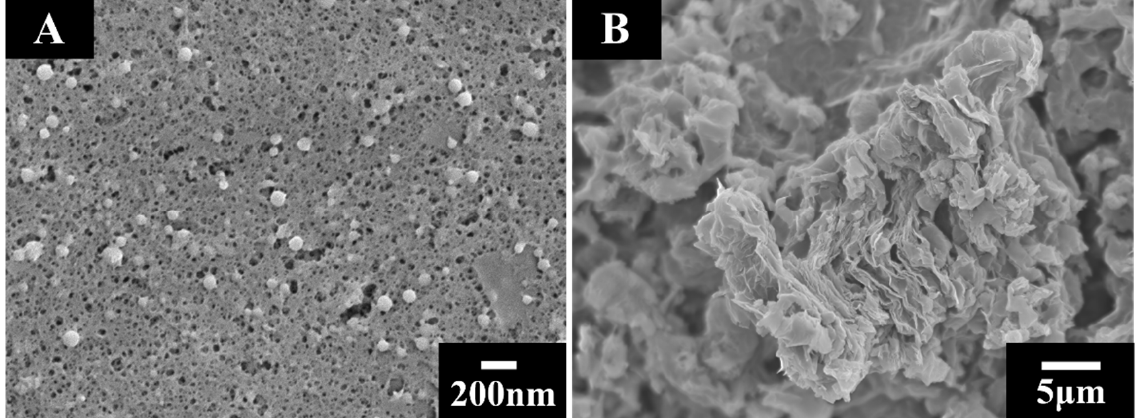
Figure 4. SEM images of films, prepared from ( A ) 0.5 gL ⁻ 1 CBXNa 2 with 0.5 gL ⁻ 1 carbon dots in water at 15 V and ( B ) 1 gL ⁻ 1 CBXNa 2 with 1 gL ⁻ 1 graphene in water at 10 V.